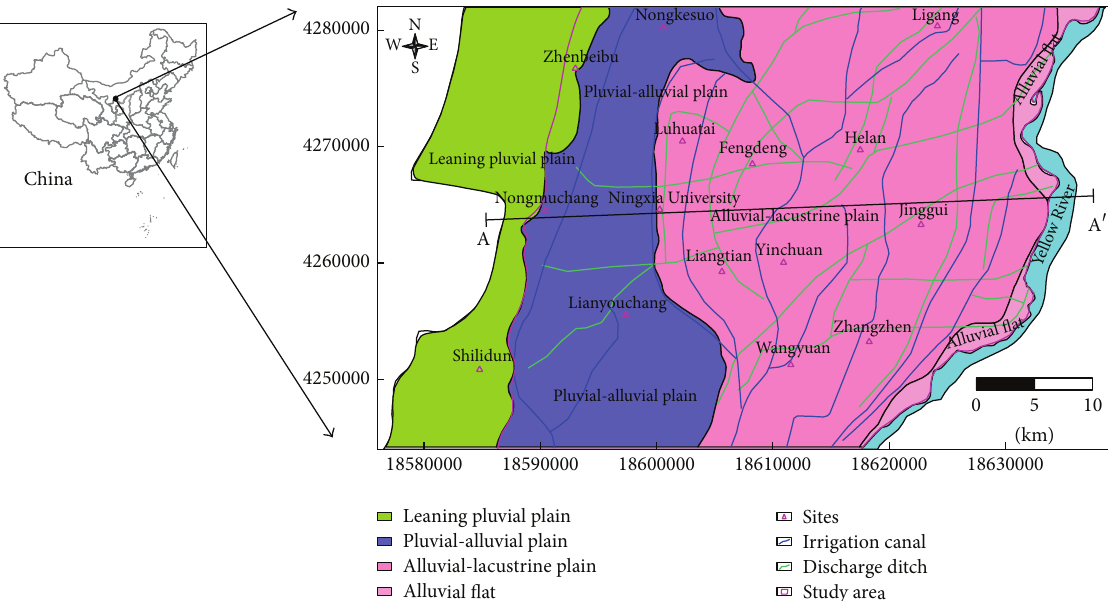
Figure 1: Location of the study area and landforms in Yinchuan, Ningxia Province, China, according to [4].